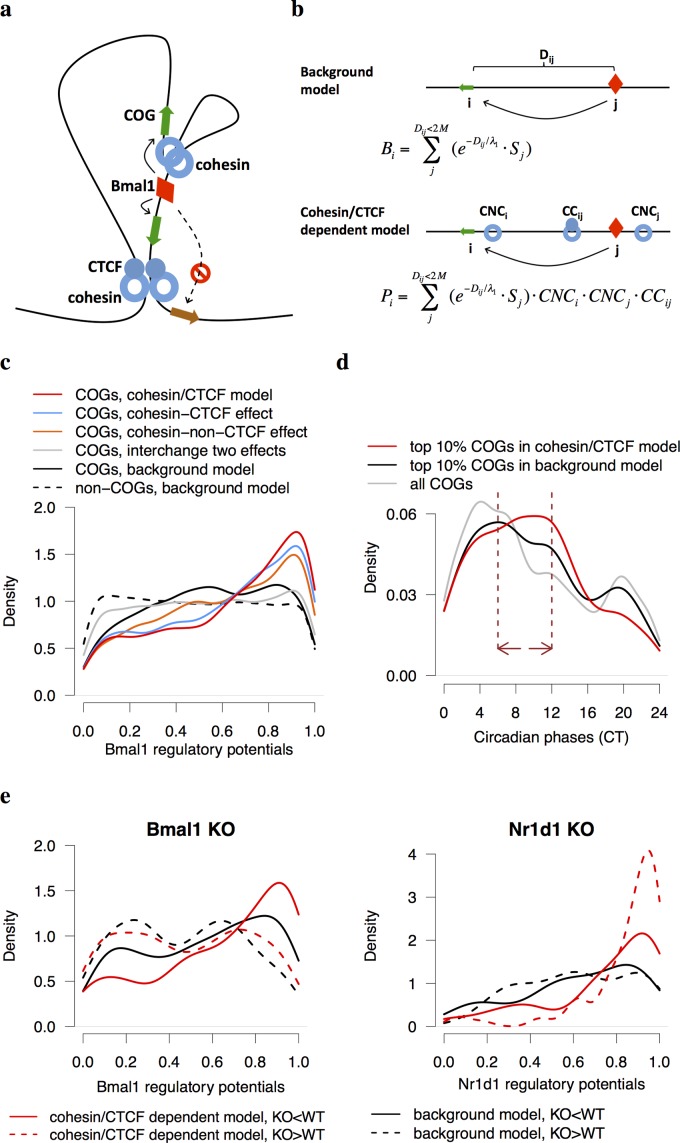
A model of circadian regulation of gene expression under high-order chromosome organization.(a) Cohesin-CTCF disrupts the gene regulation of circadian transcription factors, whereas cohesin-non-CTCF facilitates the contacts between circadian enhancers and promoters. (b) In the background model, only Bmal1 binding sites within 2 Mb of the genes were considered. In the cohesin/CTCF dependent model, the contribution of each Bmal1 binding site was further multiplied by three cohesion/CTCF dependent factors: CNCi, CNCj, and CCij (Methods). (c) The density plot of regulatory potentials in COGs or non-COGs under different conditions. The COGs in cohesin/CTCF dependent model, as well as in the model with only cohesin-CTCF or cohesin-non-CTCF effect, have significantly higher Bmal1 regulatory potentials than the background model (Kolmogorov-Smirnov test p = 10−16). The regulatory potential of the model where cohesin-non-CTCF sites and cohesin-CTCF sites were interchanged is similar with the background model. (d) The density plot of phases of COGs top ranked in two models. The enriched phase regime (CT6-CT12, dash lines) of COGs with top 10% Bmal1 regulatory potentials in cohesin/CTCF dependent model follows the peak of Bmal1 binding at CT6. (e) The density plots of differentially expressed genes in Bmal1 and Nr1d1 KO datasets. Under-expressed genes in Bmal1 KO (Fan et al., manuscript in preparation) have higher Bmal1 regulatory potentials in cohesin/CTCF dependent model than those in the background model, whereas over-expressed genes in Nr1d1 KO [9] have markedly increased in Nr1d1 regulatory potentials.